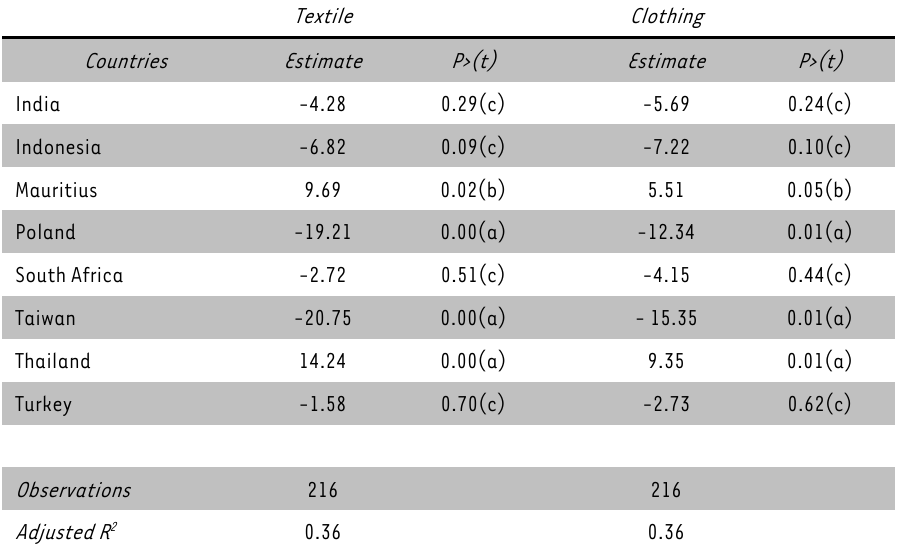
Fixed-effect panel data REER estimates (China as the benchmark) Textile Clothing Countries